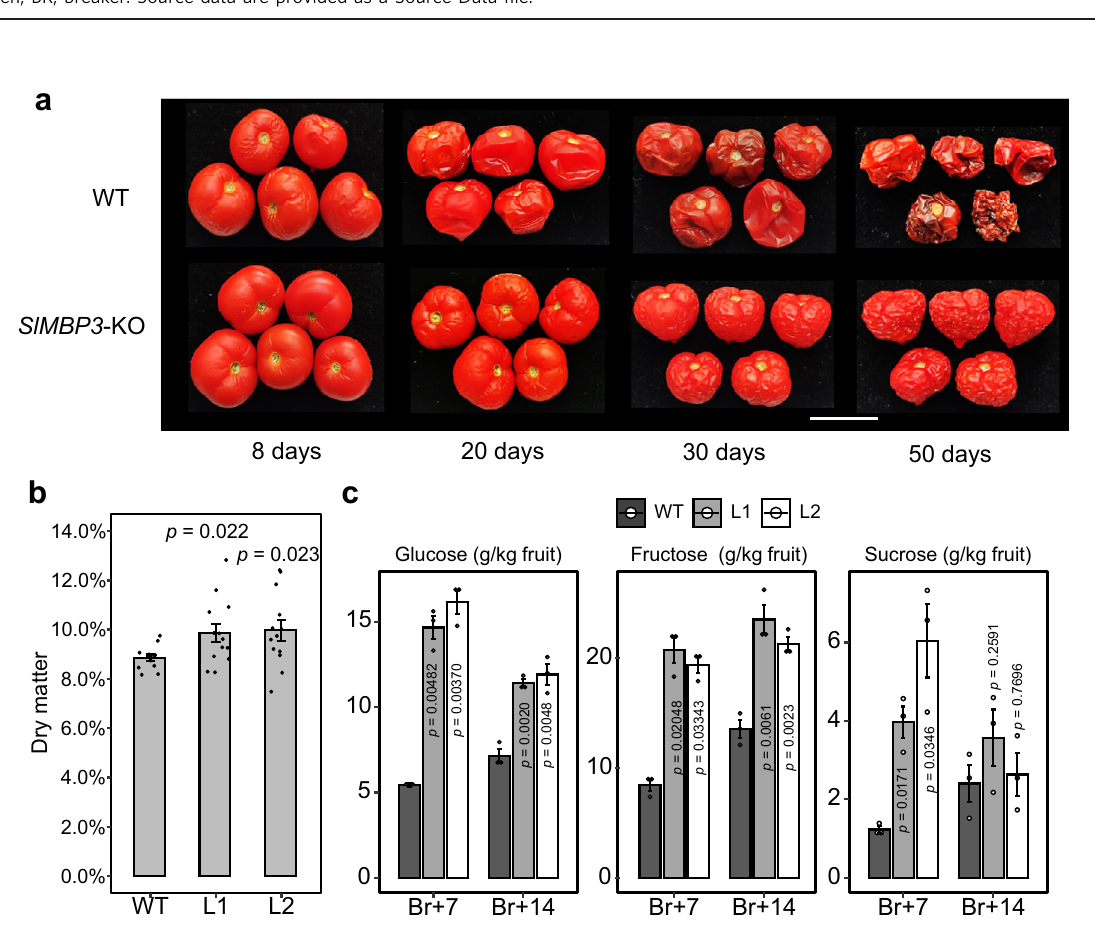
Fig. 2 Tomato fruit phenotypes of SlMBP3 and SlAGL11 loss-of-function and overexpression lines. a Cross-sections of tomato fruits of SlMBP3 and SlAGL11 knock-out and overexpressing lines throughout fruit development. SlMBP3 -KO , SlAGL11 -KO and dual SlMBP3/SlAGL11- KO lines were obtained by CRISPR/Cas9-induced mutation as described in Supplementary Fig. 4. Overexpression was achieved by introducing a SlMBP3 and SlAGL11 driven by the 35S-CaMV promoter. Scale bar = 1 cm. b Histological observations of fruit with altered SlMBP3 and SlAGL11 expression. Fruit sections at 30-DPA fruits and 10-DPA fruits were stained with toluidine blue. DPA refers to days post-anthesis. Yellow arrows point to the locular tissue. Black bar = 5 mm and white bar = 1 mm. c Assessing fi rmness of tomato fruit in SlMBP3 and SlAGL11 mutant lines. Fruit fi rmness was monitored at different stages of fruit development and ripening. Values are means ± SD of ten fruits per stage for each individual line, and signi fi cance was determined by two-tailed Student ’ s t -test. MG, mature green; BR, breaker. Source data are provided as a Source Data fi le.